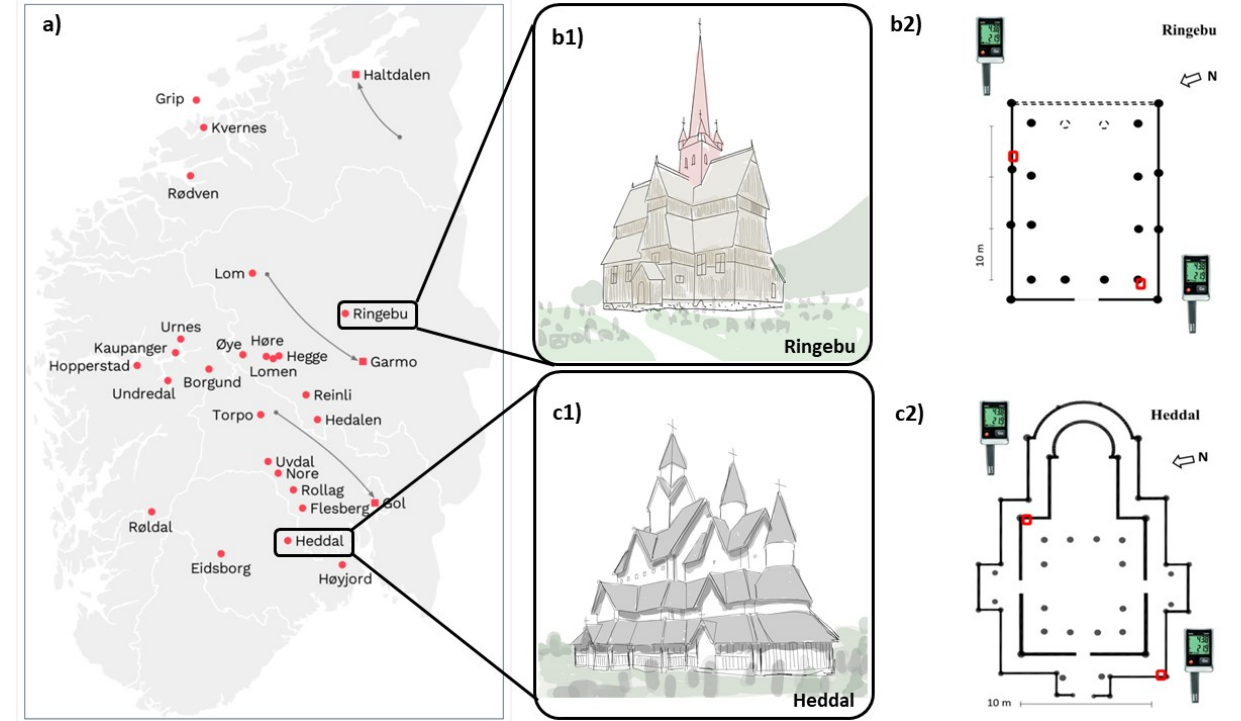
Figure 1. ( a ) Map of southern Norway with highlighted the locations of the still existing 28 Stave churches (red dots) after preserved stave churches in Norway by Store norske leksikon (https://snl.no/ accessed on 12 May 2022). ( b1 ) Map and Hand drawn sketch of Ringebu Stave church adapted by [21]. ( b2 ) Horizontal plan with scale unit, northern direction and locations of the indoors dataloggers installed indoors in Ringebu. ( c1 ) Hand drawn sketch of Heddal Stave church. ( c2 ) Horizontal plan with scale unit, northern direction and locations of the indoors dataloggers installed indoors in Heddal. Subplots ( b1 ) and ( c1 ) have been drawn by Elena Sesana. The microclimatic data were collected by means of Testo 175H1 dataloggers, char- acterized by a precision of 0.4 ◦ C and 1% RH and a resolution of 0.1 ◦ C and 0.1%